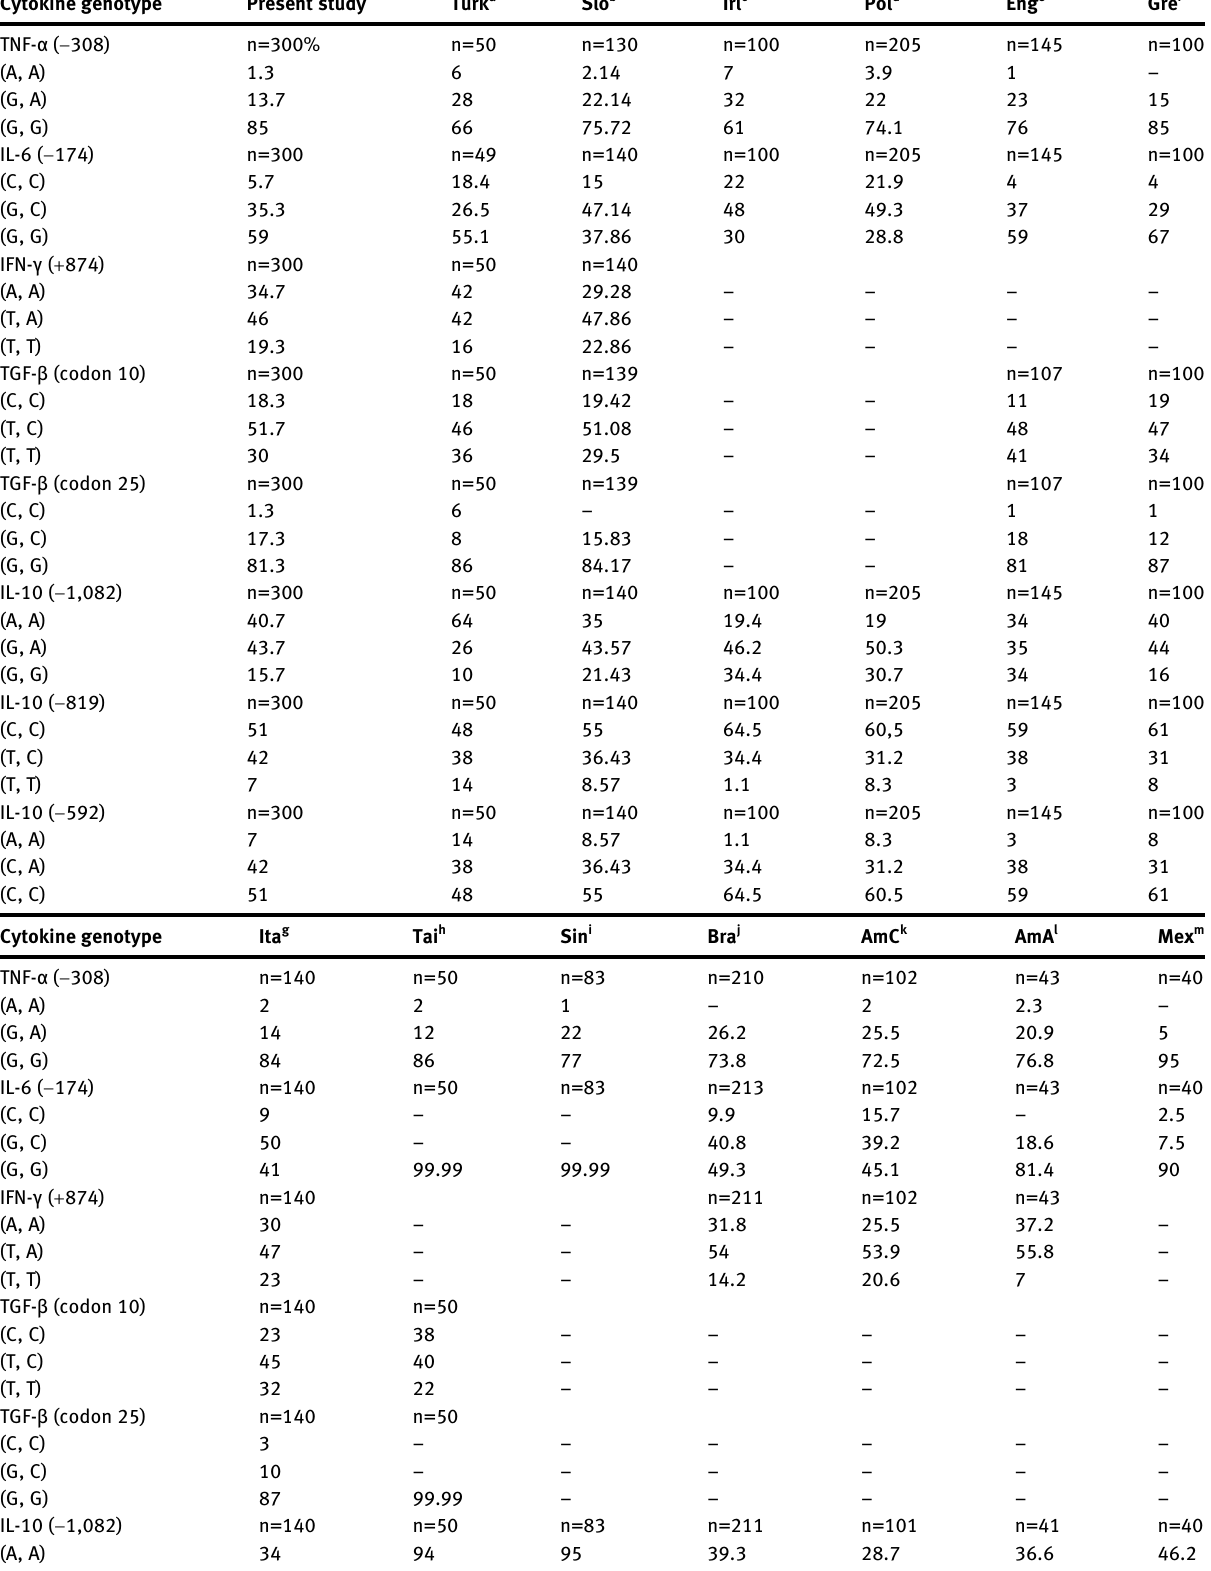
Table  : Genotype frequencies of the study group and their comparison with the frequencies of different ethnic groups. Cytokine genotype